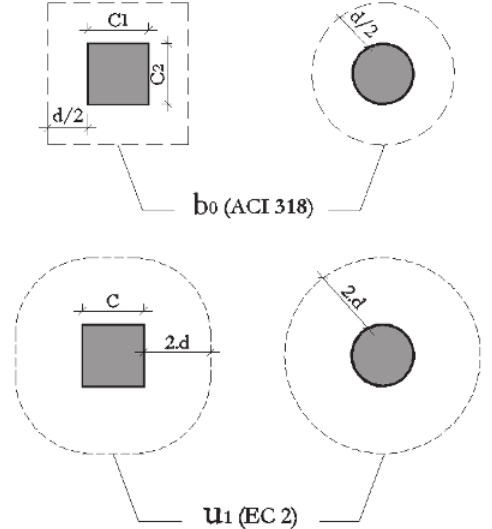
Figura 2 Perímetros de controle segundo as normas ACI 318 [11] e EC 2